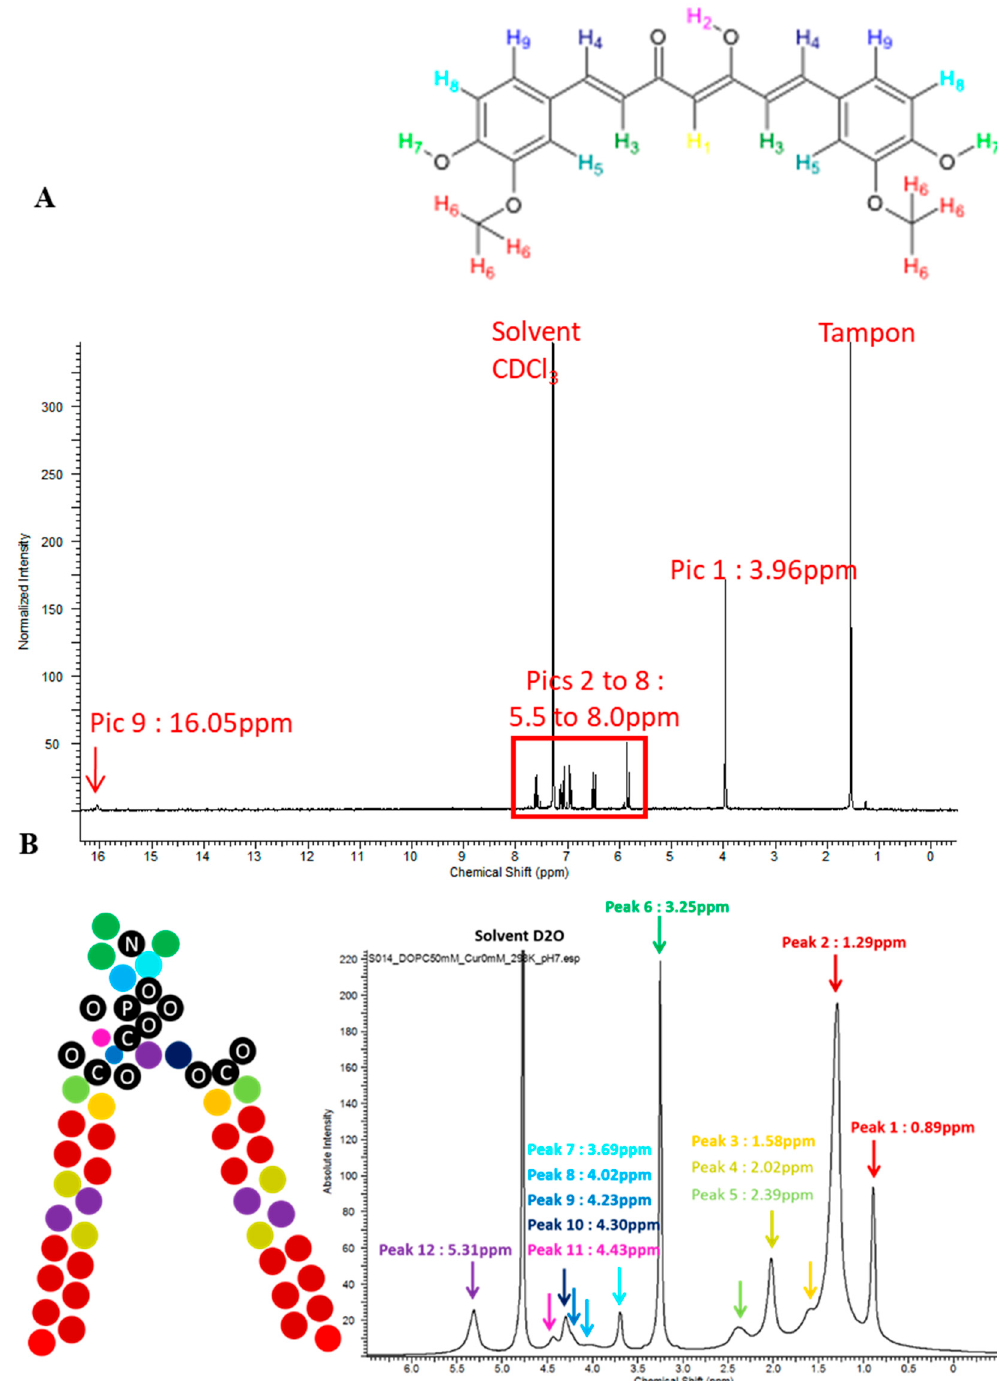
Figure 6. 1 H NMR spectrum of curcumin in deuterated chloroform ( A ) and attribution of dioleoylphosphatidylcholine (DOPC) ( B ). C: Carbon. O: Oxygen. P: Phosphorus. N: Nitrogen. Colored balls: Hydrogen, CH 3 , CH 2 , and CH groups.